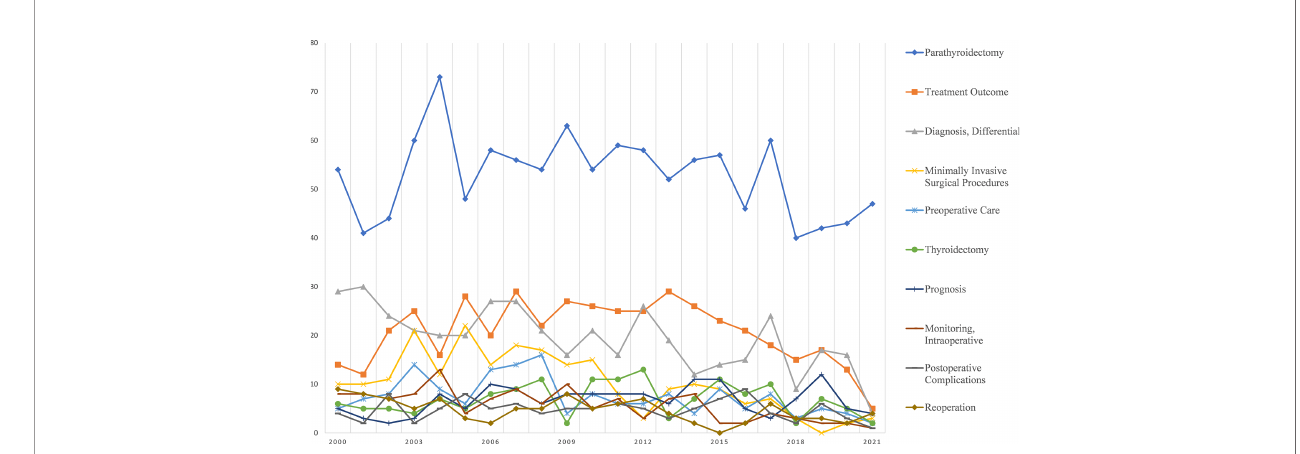
FIGURE 3 | Research foci trends related to treatment.